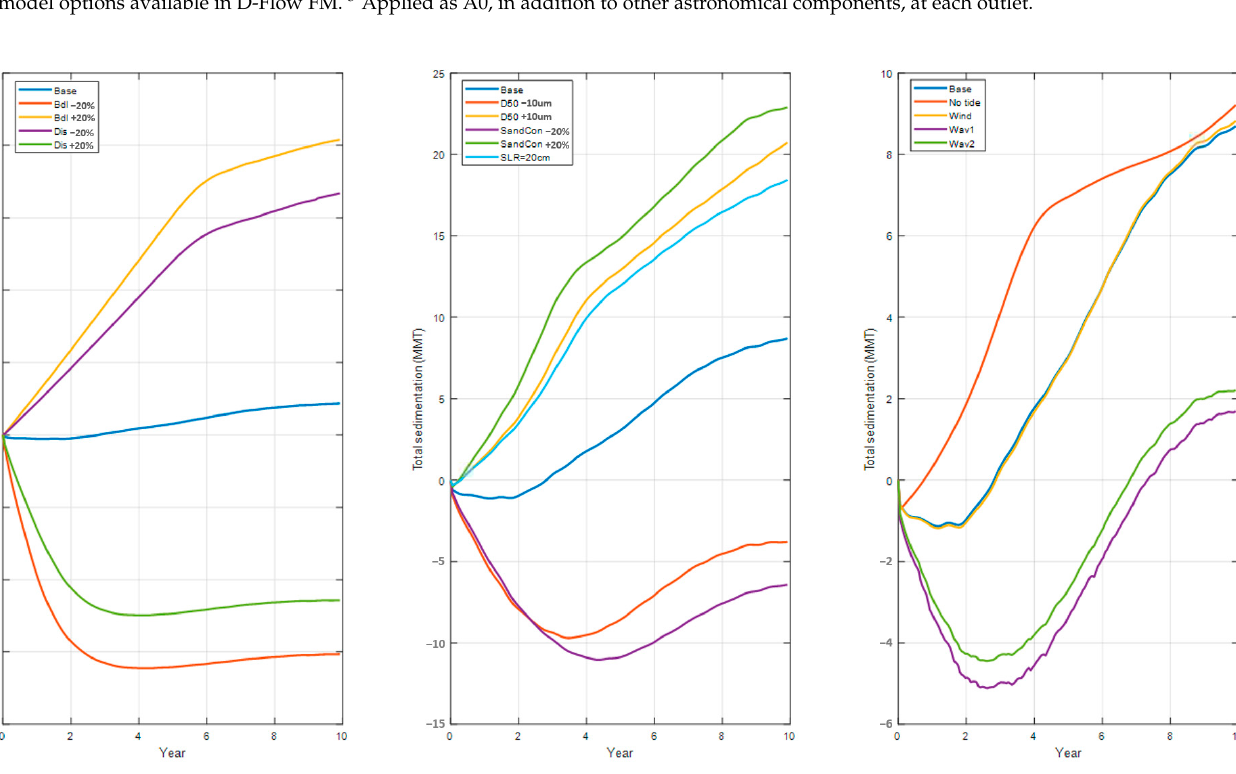
Figure 9. Time series of the total sedimentation (MMT) with various factor settings for L2a. Note that the three subfigures have different vertical scales.